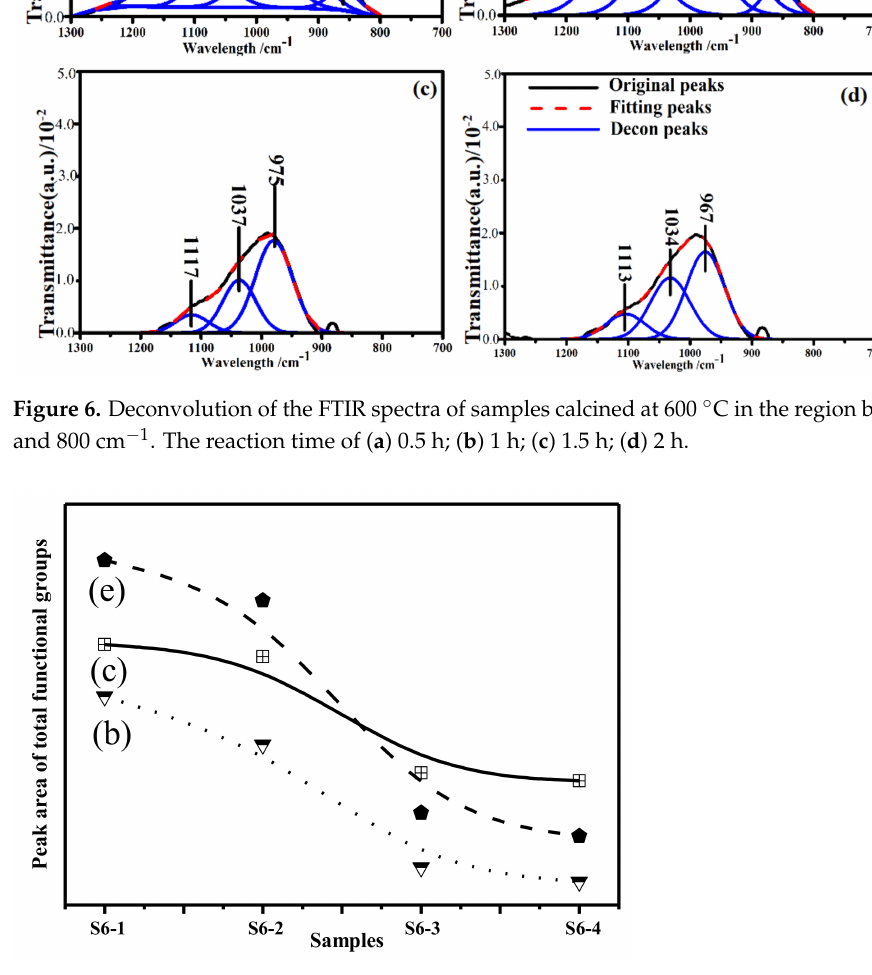
Figure 7. Variation of functional groups after alkaline activation. ( b ) Asymmetric stretching of (Si, Al)-O-Si in Q 3 units; ( c ) Symmetric stretching of Si-O-Si in Q 2 units; ( e ) Asymmetric stretching of (Si, Al)-O-Si in amorphous